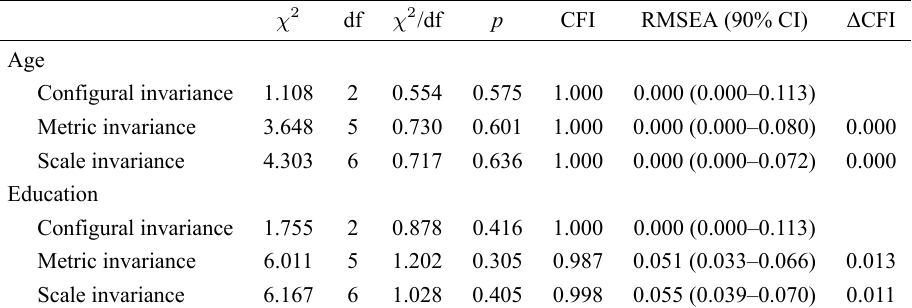
Table 6. Measurement invariance tests of the PCIBS across age and